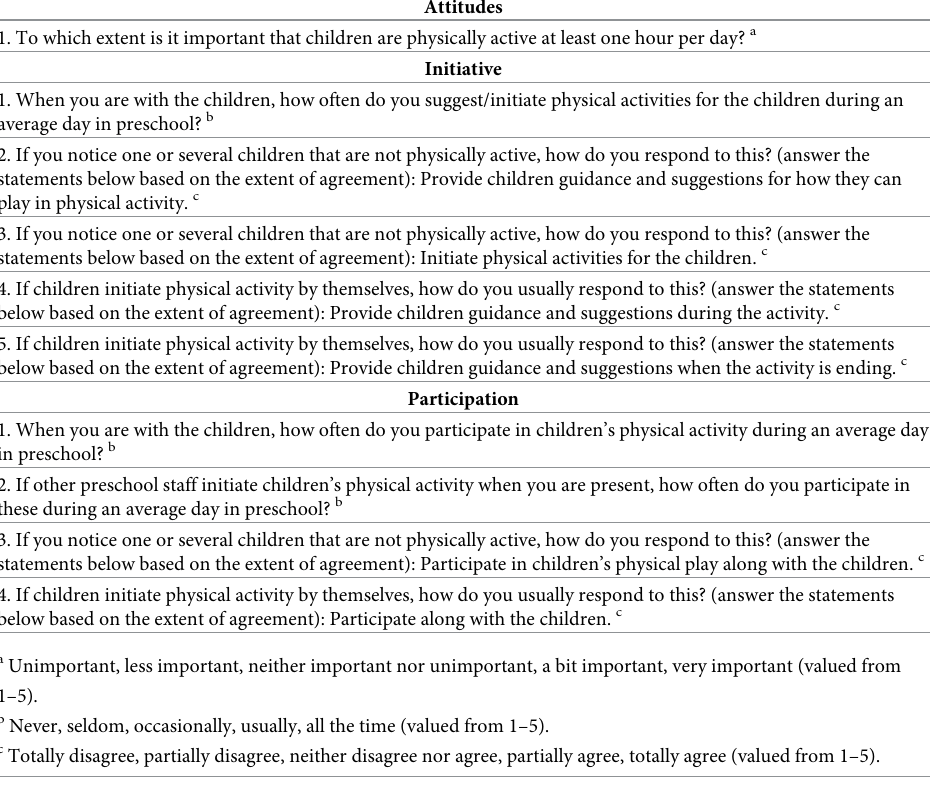
Table 3. Variables concerning the concept of attitude, initiative and participation, with numbers and descriptions of questions with reply options ( a,b,c ).